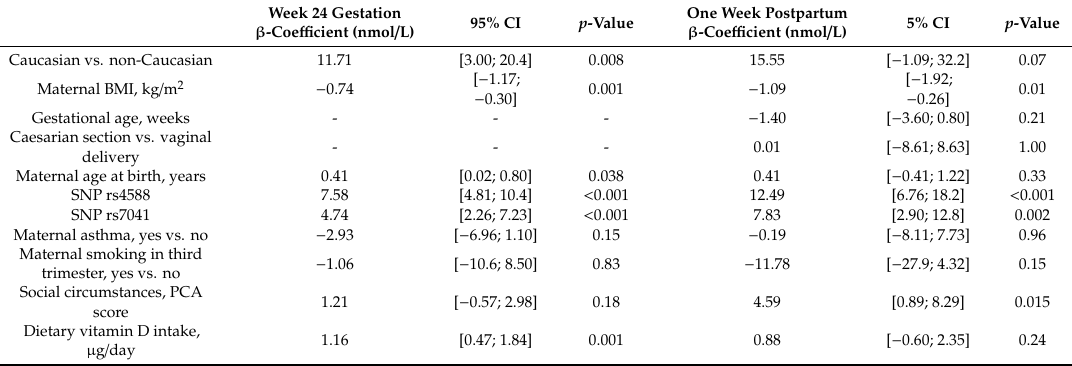
Table 1. Univariate analyses of determinants for maternal season-adjusted 25(OH)D levels during